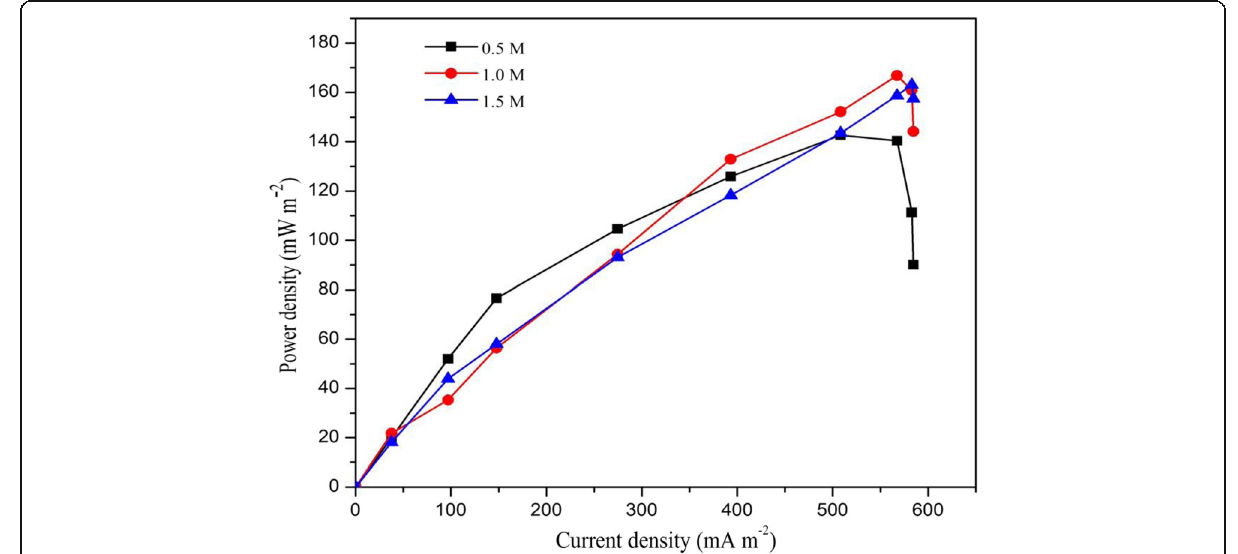
Fig. 6 Power density characteristics against current denstiy for different concentrations of pottasium ferricyanide